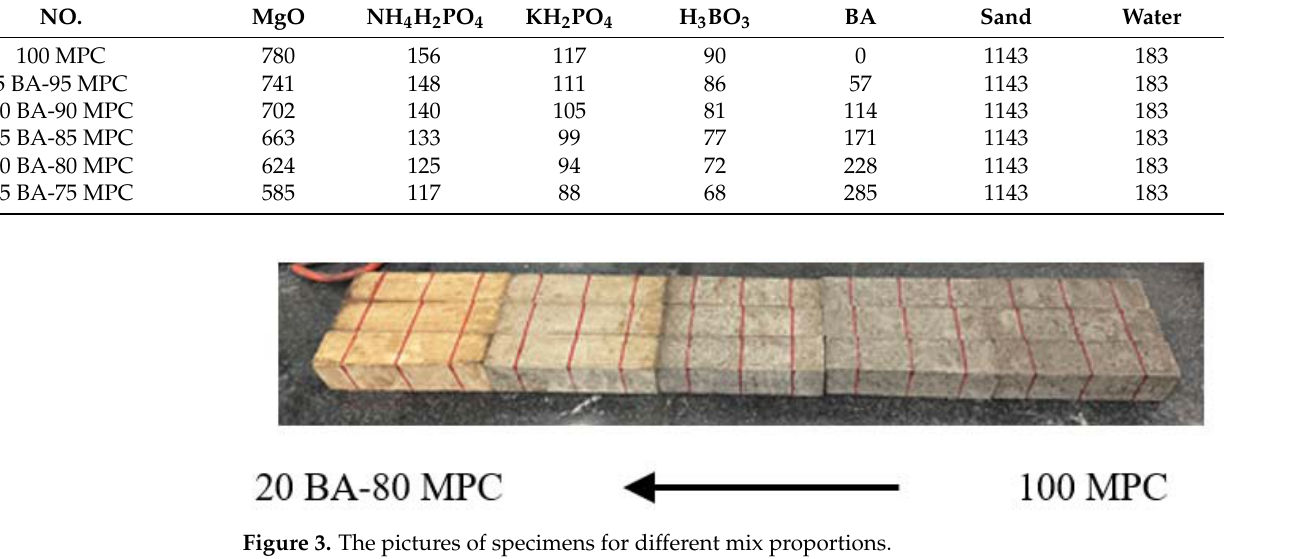
4 of 18 Figure 2. Particle ‐ size distributions of Bas by laser diffraction method. The mix ratio for the control group was determined according to the previous exper ‐ imental results [4]. A series of BA ‐ MPC mortars were designed, as shown in Table 2. The preparation process of the mortar specimen is shown as follows: first, all powder materials